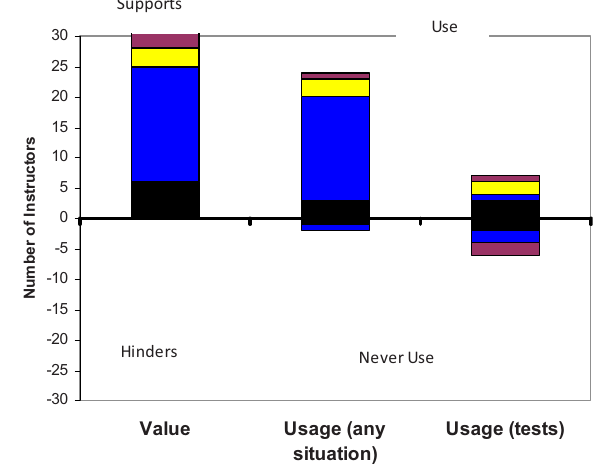
FIG. 7. (cid:1) Color (cid:2) Value and usage of problem features related to the teaching goal of monitoring students’ thinking. The legend is in Fig. 3. The only problem feature linked to this goal was multiple choice.